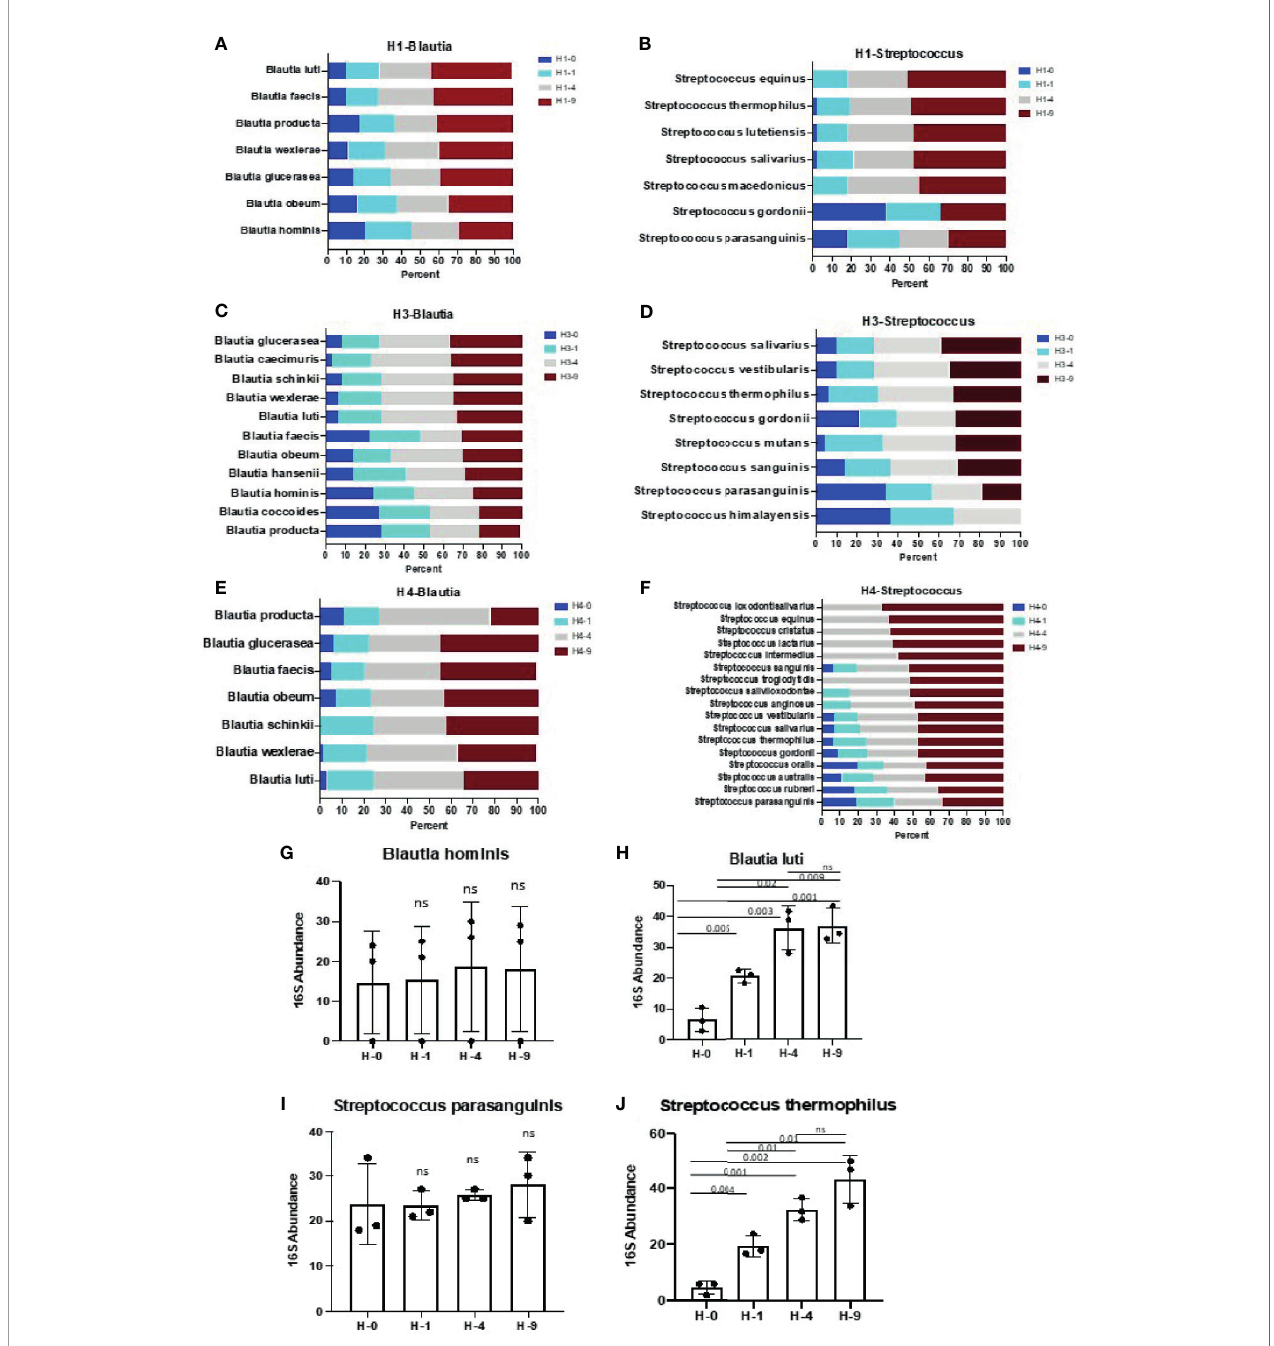
FIGURE 5 | Species of genus Blautia and Streptococcus show differential sensitivity to bead- beating treatment. Panels (A – F) illustrate the abundance of various species of Blautia and Streptococcus at four (0, 1, 4, and 9 min) bead-beating conditions in three human stool samples (H1, H3, H4). Relative abundance of various species of Blautia and Streptococcus at each condition is plotted in bar graphs. Relative abundance was calculated based on number of full length 16S rRNA sequencing reads supporting a given taxon in each condition. Panel (G) shows abundance of Blautia hominis at four different bead-beating conditions in human stool. Panel (H) shows abundance of Blautia luti at different bead-beating conditions in human stool. Panel (I) shows abundance of Streptococcus parasanguinis at four different bead-beating conditions in human stool. Panel (J) shows abundance of Streptococcus thermophilus at different bead-beating conditions in human stool. The y-axis shows the 16S abundance of detected bacteria and the x-axis shows different beating conditions. Numeric data were compared using t-test statistics and a p-value <0.05 was considered signi fi cant. “ ns ” denotes “ Not signi fi cant ” . Sample IDs denotes H-0: 0 min, H-1: 1 min, H-4:4 min, and H-9:9 min of bead-beating